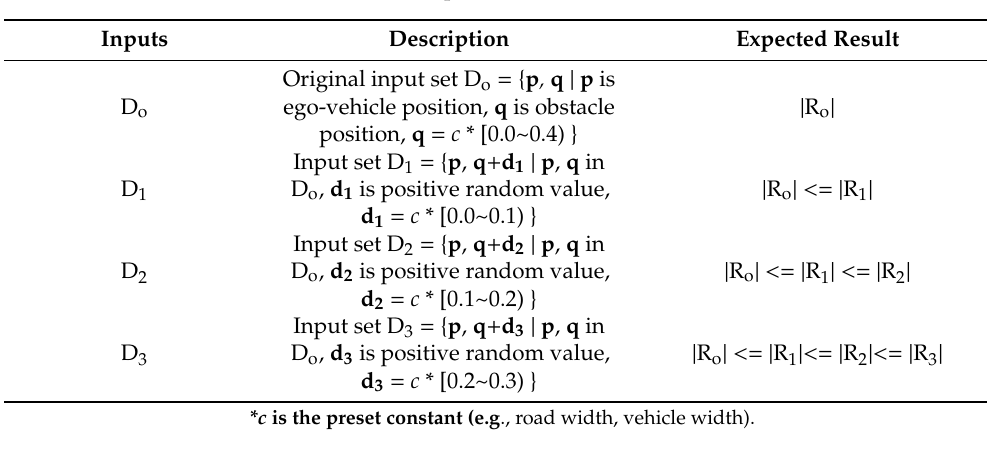
Table 5. Test inputs for the avoidance test.